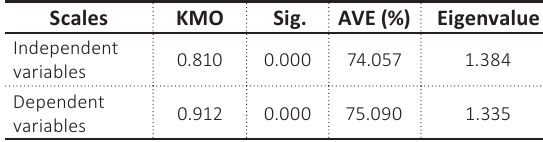
Table 3. Results of EFA